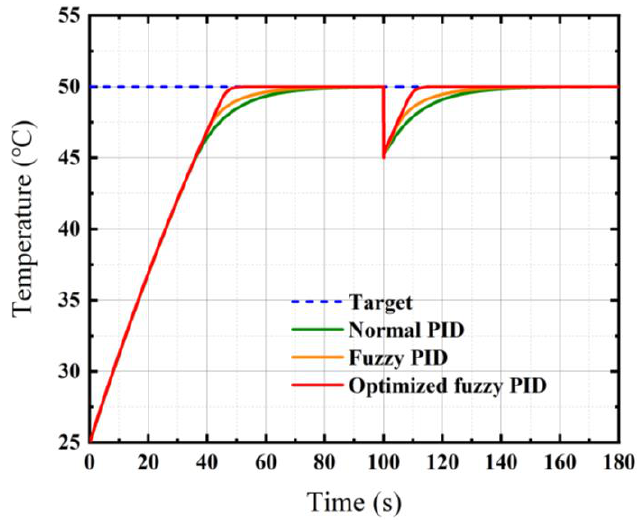
Figure 9. Comparison of temperature control performance while a disturbance was added. Table 6. Comparison of settling time for three control methods while a disturbance was added.